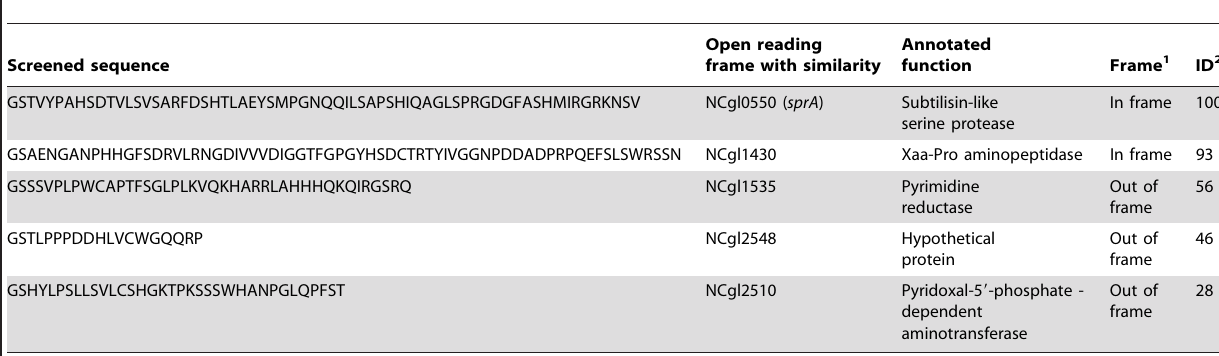
Table 1. Screened proteins and peptide sequences that interact with GlxR.